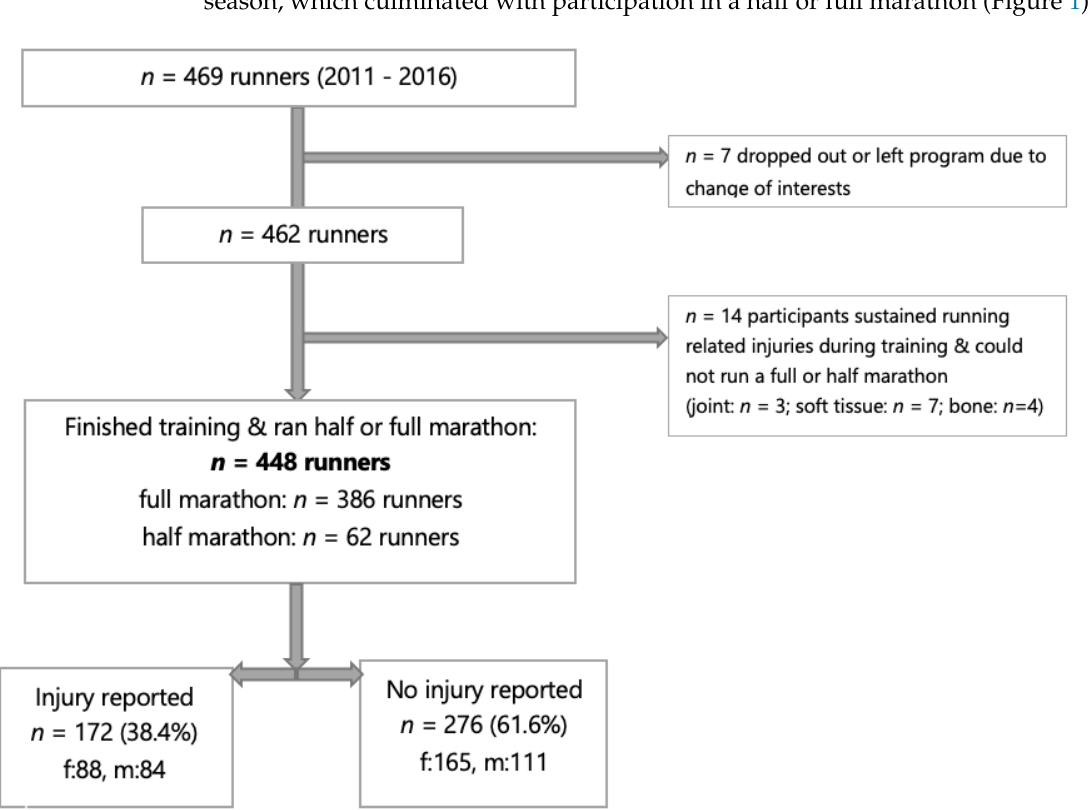
Figure 1. Participants who entered and completed the program, with or without injury.